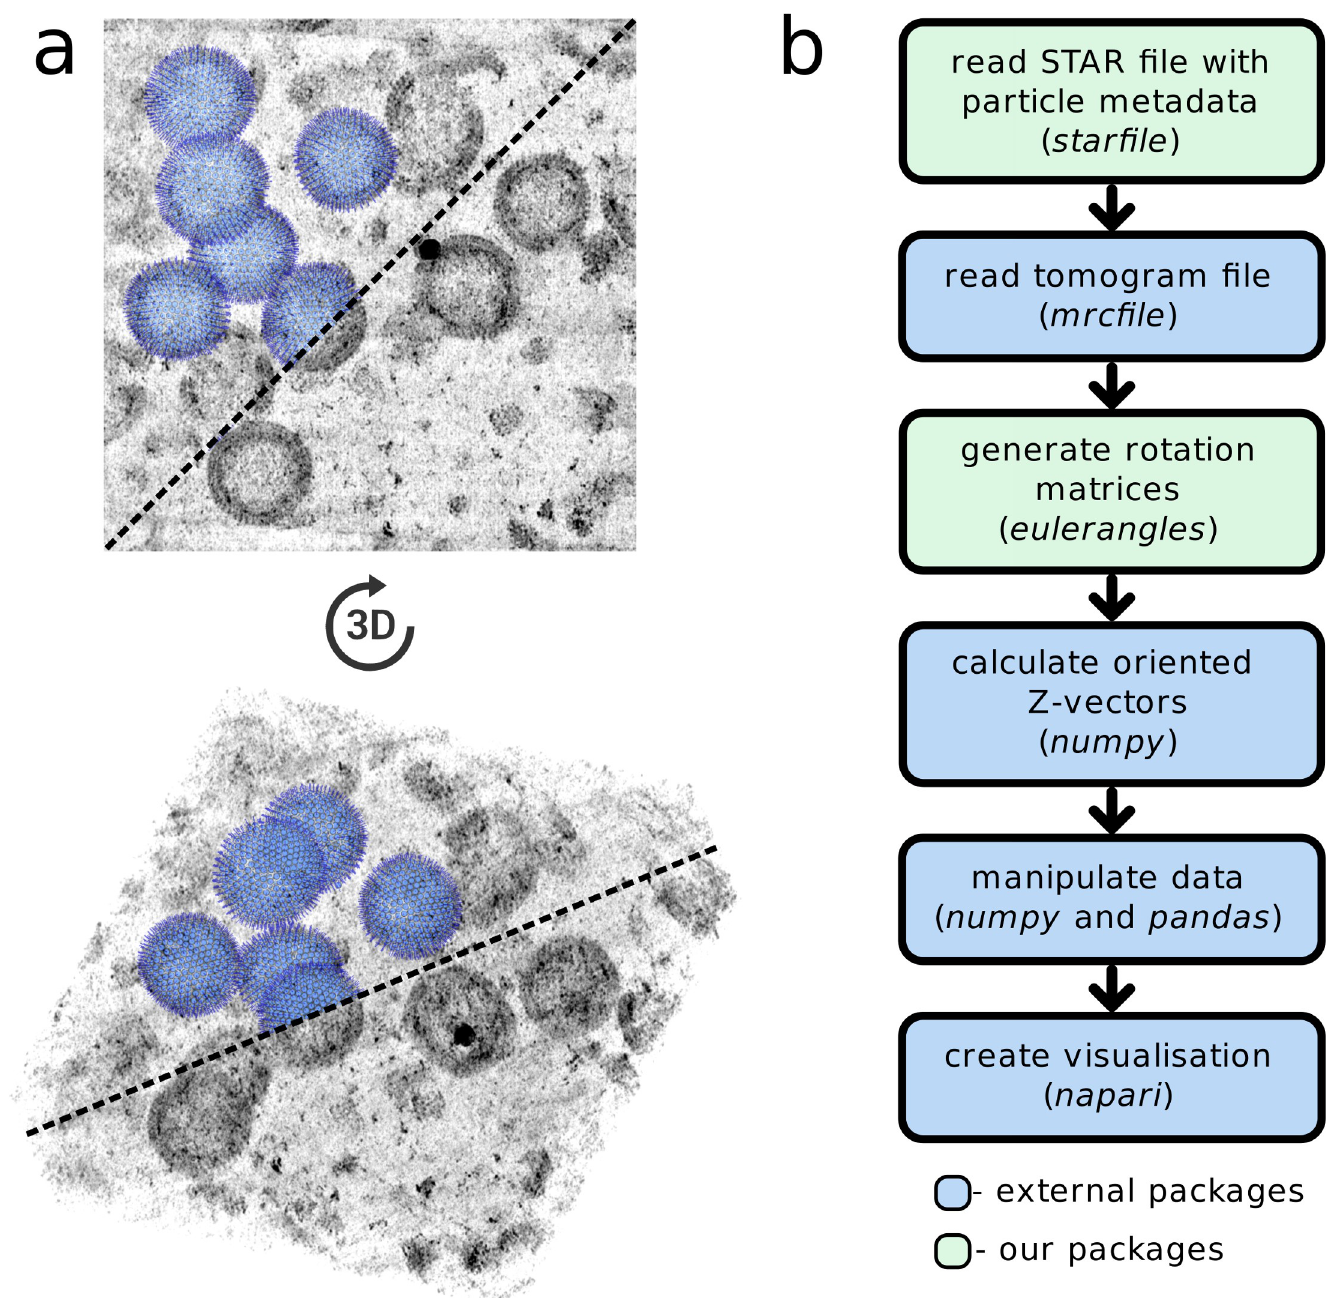
Fig 2. Modular tools designed to integrate with the scientific Python ecosystem simplify the creation of custom visualisations in napari . (a) Particle positions and orientations, easily accessed and manipulated using starfile and eulerangles , are rendered in 3D with the imaging data from which they were derived. (b) A flowchart of the process for creating the visualisation in (a) demonstrates the benefits provided by an interface with the scientific Python